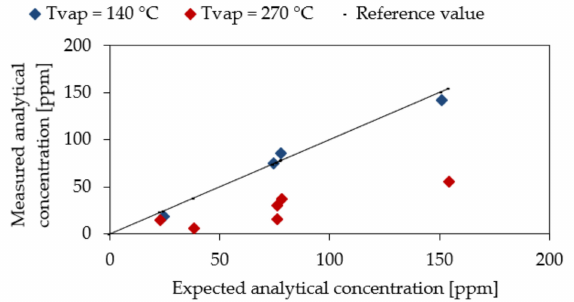
Figure 3. Scatter diagram of between concentration of butanol measured by the chromatograph (C yOH expressed in ppm of butanol) and the concentration expected due the generation process (C xOH